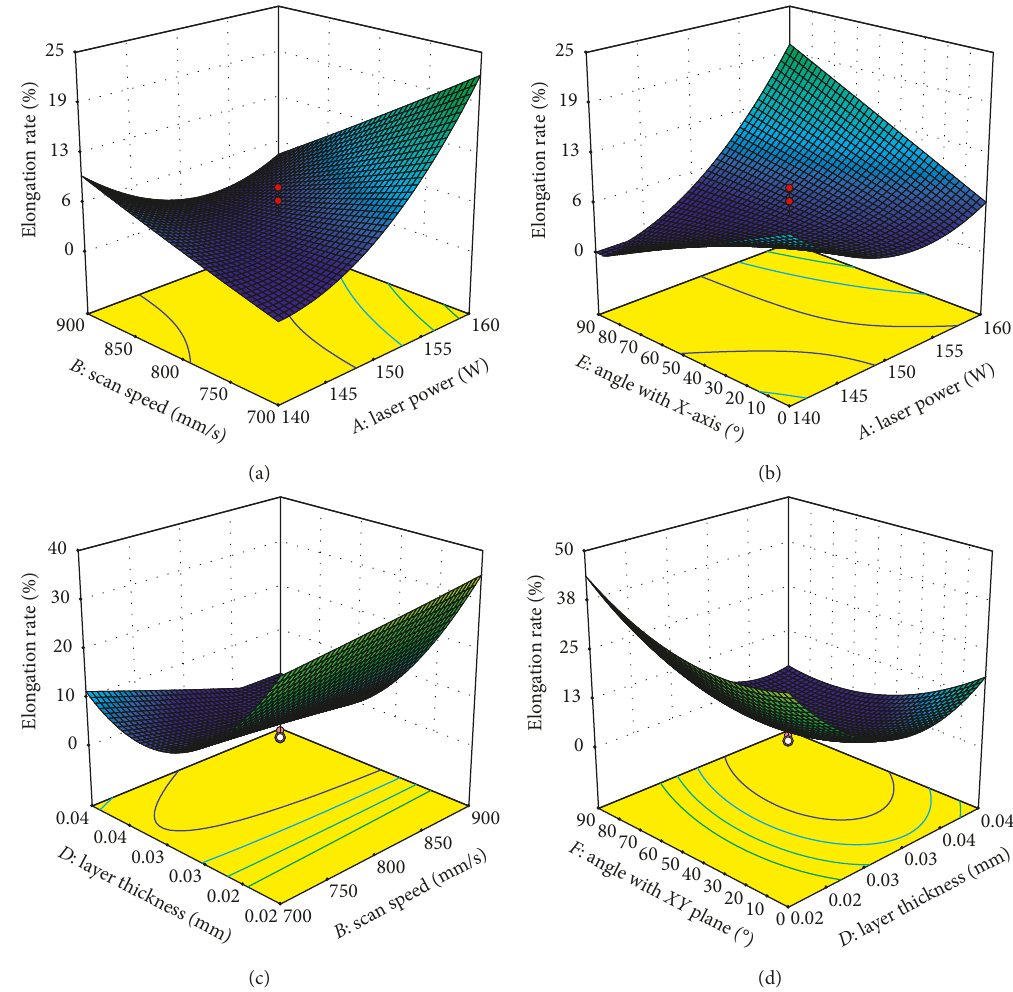
Figure 9: Effect of laser power, scan speed, scan spacing, layer thickness, angle with xz plane, and angle with xy plane on elongation. (a) Effect of interaction of scan speed and laser power on elongation. (b) Effect of interaction of angle with the xz plane and laser power on elongation. (c) Effect of interaction of scan speed and layer thickness on elongation. (d) Effect of interaction of angle with the xy plane and layer thickness on